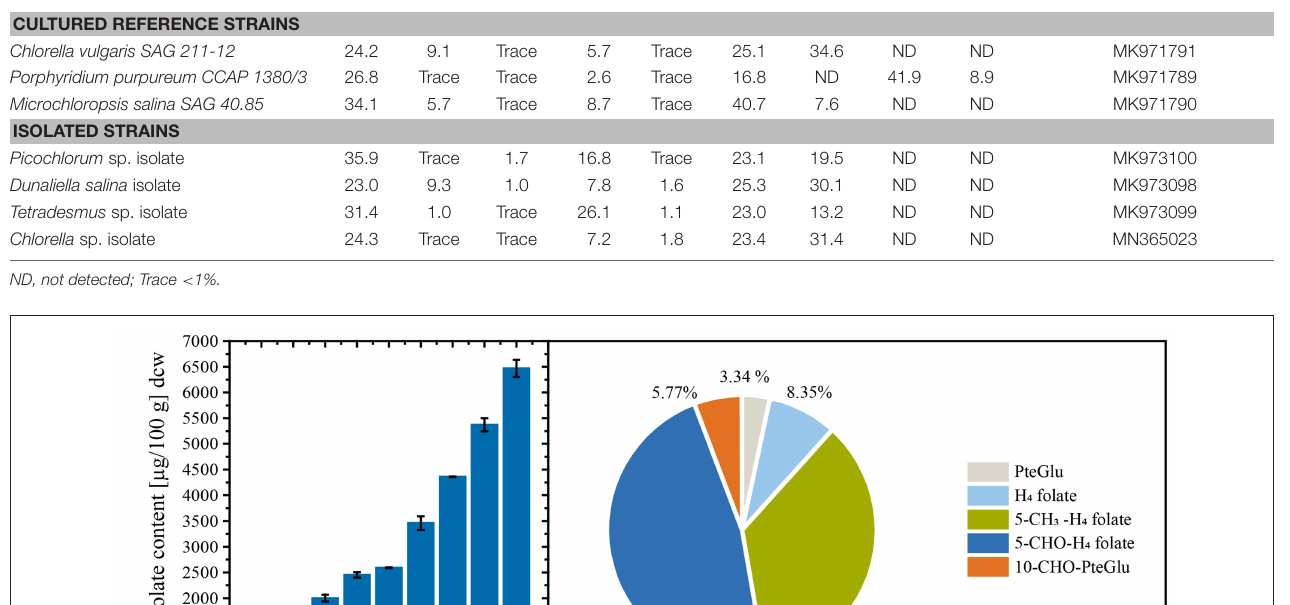
TABLE 2 | Fatty acid composition of microalgae samples by GC-FID analysis. Fatty acid methyl esters (FAME)